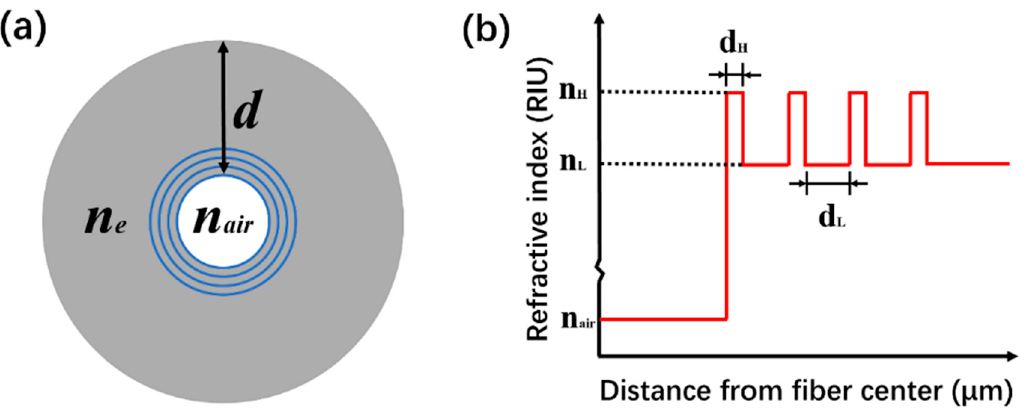
Figure 1. ( a ) Schematic diagram of the cross-section of the HCBF; ( b ) refractive index distribution along the fiber radial direction.